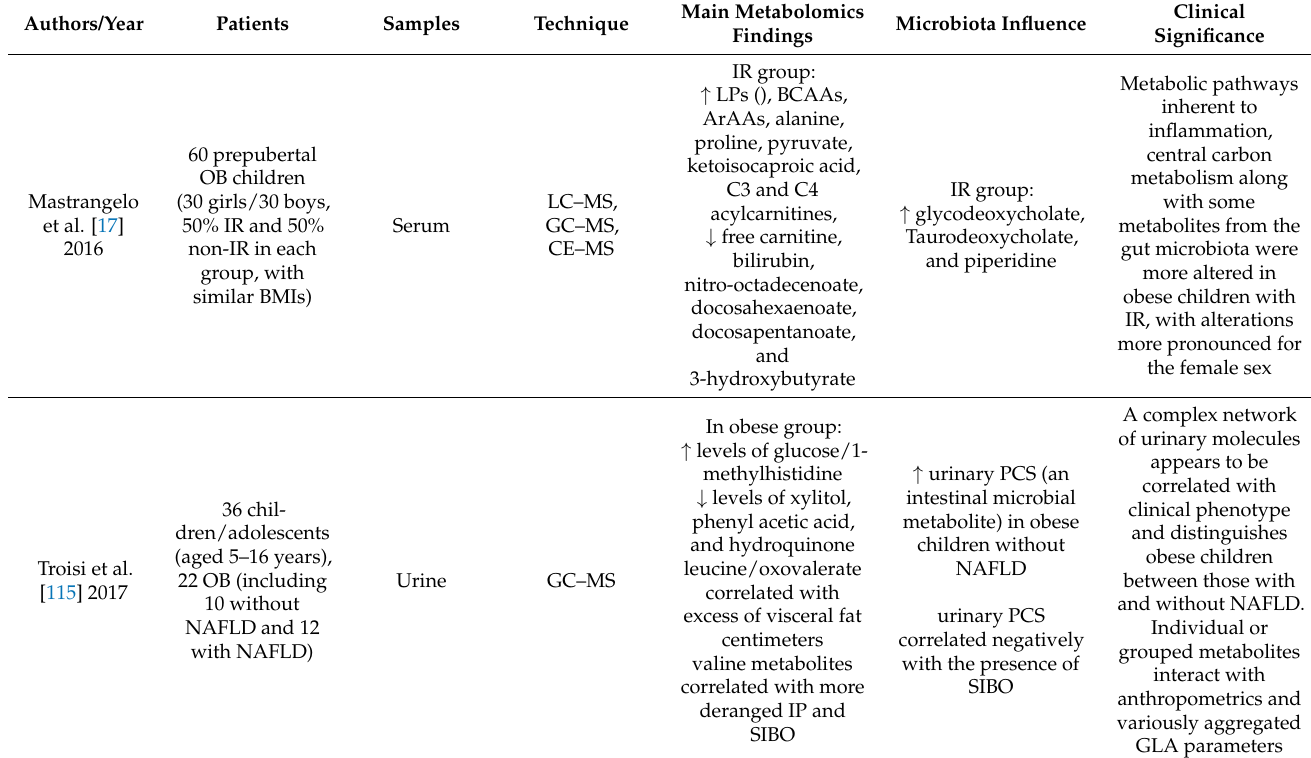
Table 1. Metabolomics and microbiomics